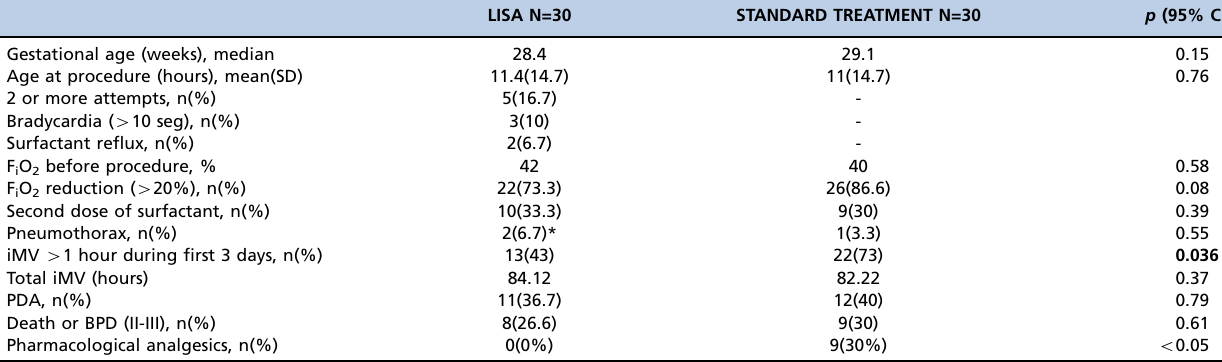
Table 3 - Postnatal respiratory management of less invasive surfactant administration and INSURE groups. LISA N=30 STANDARD TREATMENT N=30